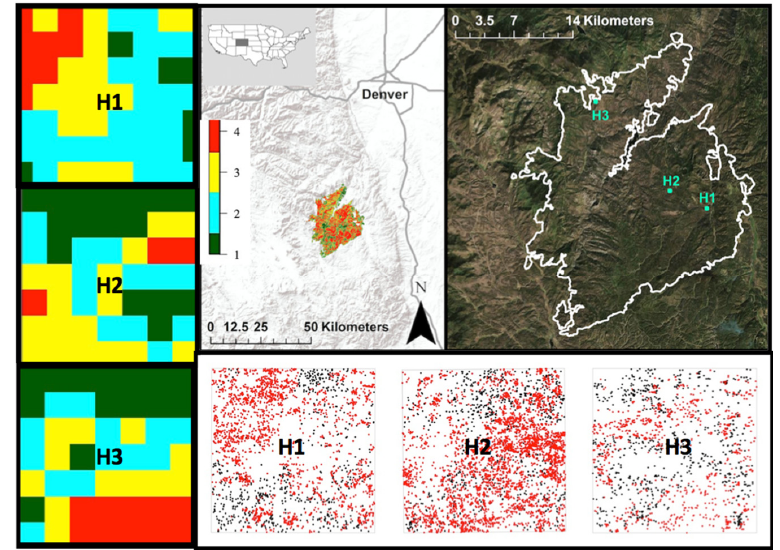
Figure 1. The Hayman Fire and plot (H1, H2, and H3) locations in the Colorado Front Range, USA. Within each plot, residual trees (black points) are shown relative to post ‐ fire regeneration (red points) (bottom row). Esri basemap layers: the World Terrain Reference shows the Hayman Fire in relation to Denver and World Imagery denotes topography and forest cover in relation to plot locations within the fire. Monitoring trends in Burn Severity (MTBS) shows the mixed ‐ severity fire effect in the Hayman Fire. Thematic burn severity classes include unchanged (green), low ‐ (cyan), moderate ‐ (yellow), and high ‐ (red) severity (left side; scale is 4 ha).